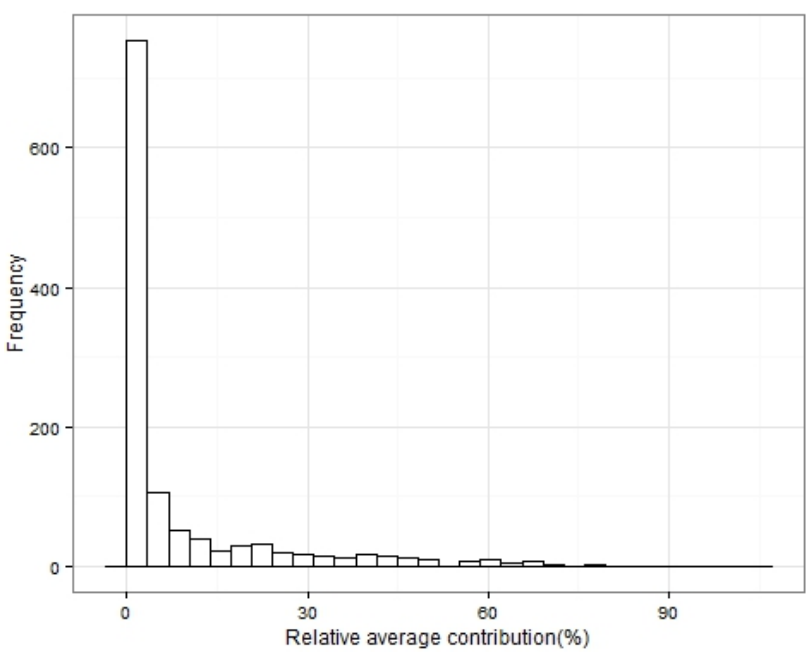
Figure 3. Distribution of the relative contribution of the auxiliary term to the energy consumption of all trips.